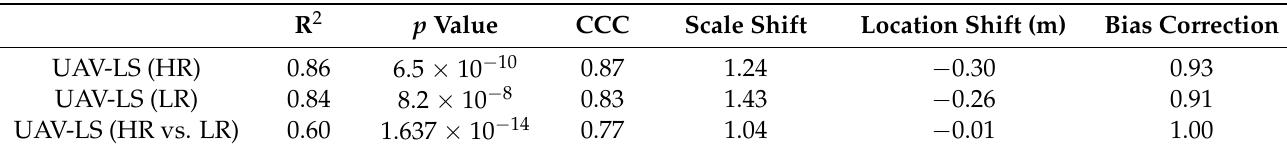
Table 4. Linear regressions and CCC of the height estimations using the Gaussian approach. For the top 2 rows, the benchmark data set is used as validation.